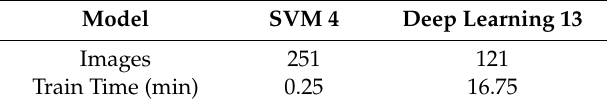
Table 8. SVM and deep-learning training time.